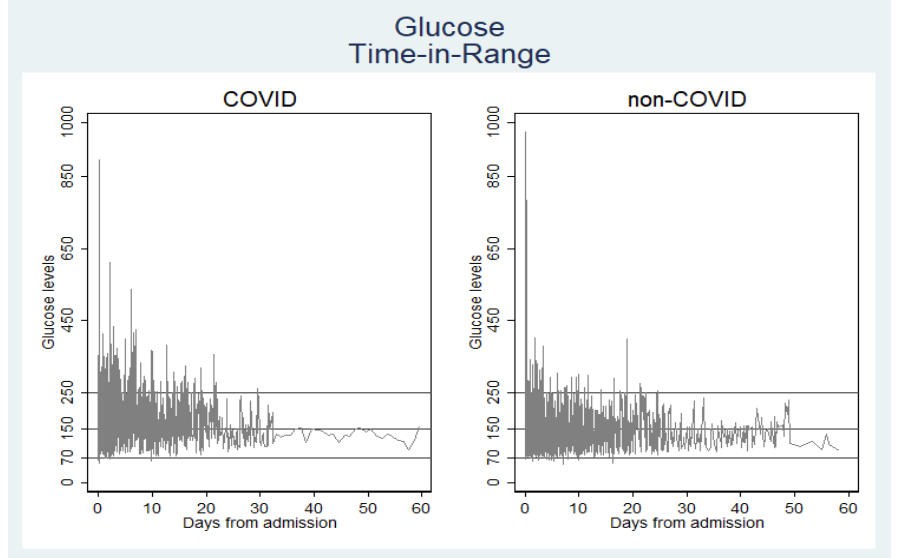
Figure 1. Stagger diagram comparing glucose levels spread over time and range among the COVID-19 and non-COVID-19 study population.